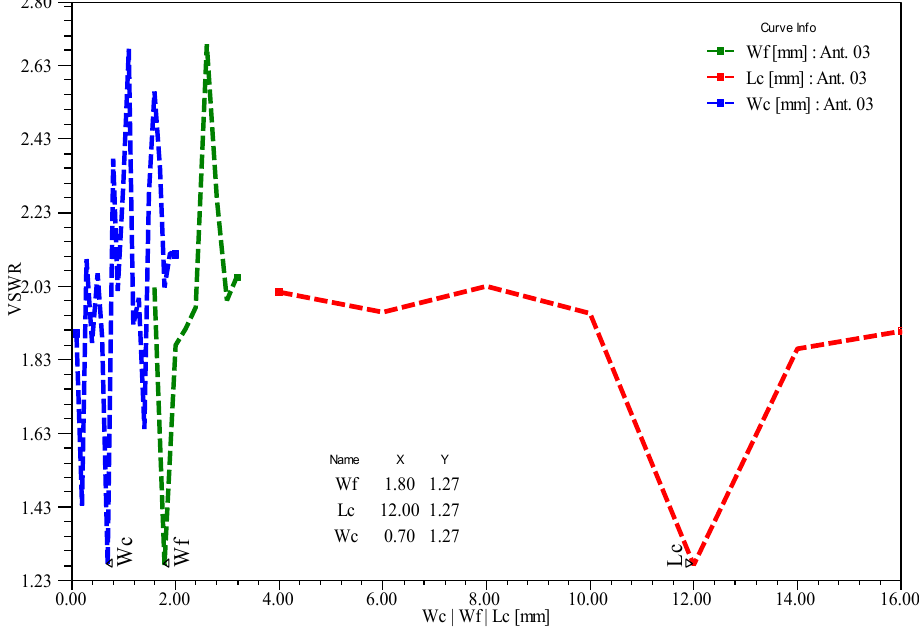
Figure 11. VSWR of Slot antenna 3 at 2450 MHz versus Wc, Wf, and Lc (mm).